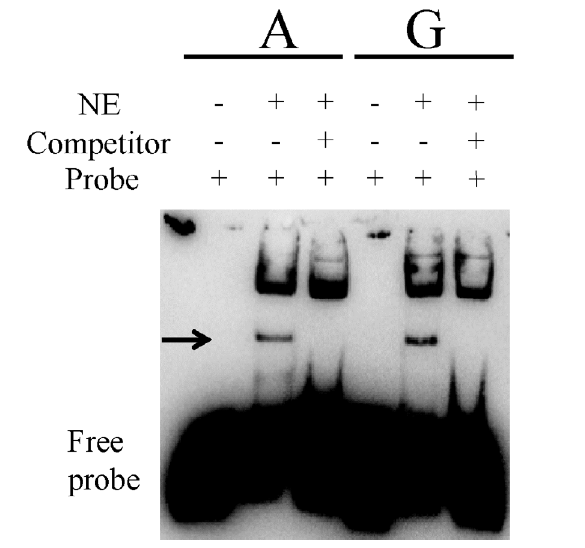
Figure 5 – Difference in the binding affinity between MCF-7 nuclear proteins and rs72755295 alleles in EMSA. The top line indicates different alleles. NE denotes nuclear protein, and the arrow points out the position of protein-probe